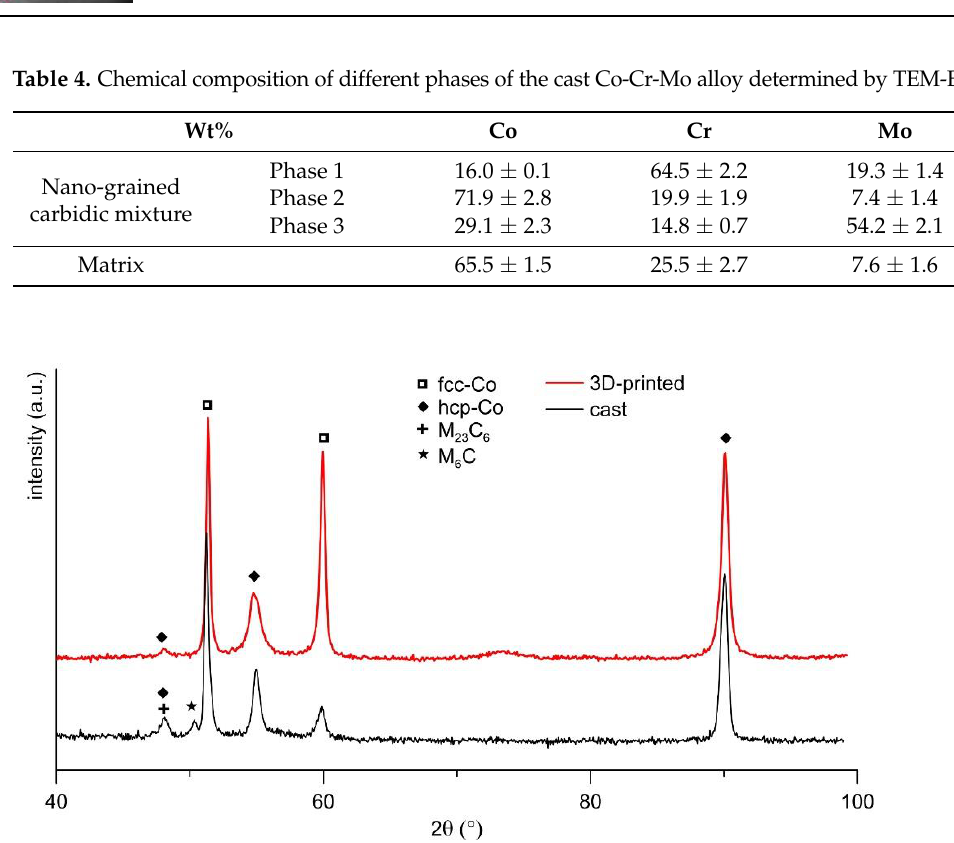
Figure 6. X-ray diffraction (XRD) diffraction patterns of cast and 3D-printed Co-Cr-Mo alloy. Figure 9 indicates the microstructural changes during annealing at different